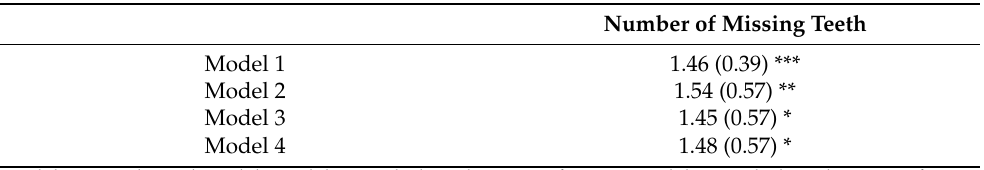
Table 4. Crude and adjusted linear regression models and correspondent standard error of OHIP-14 total score towards number of missing teeth ( n = 93).